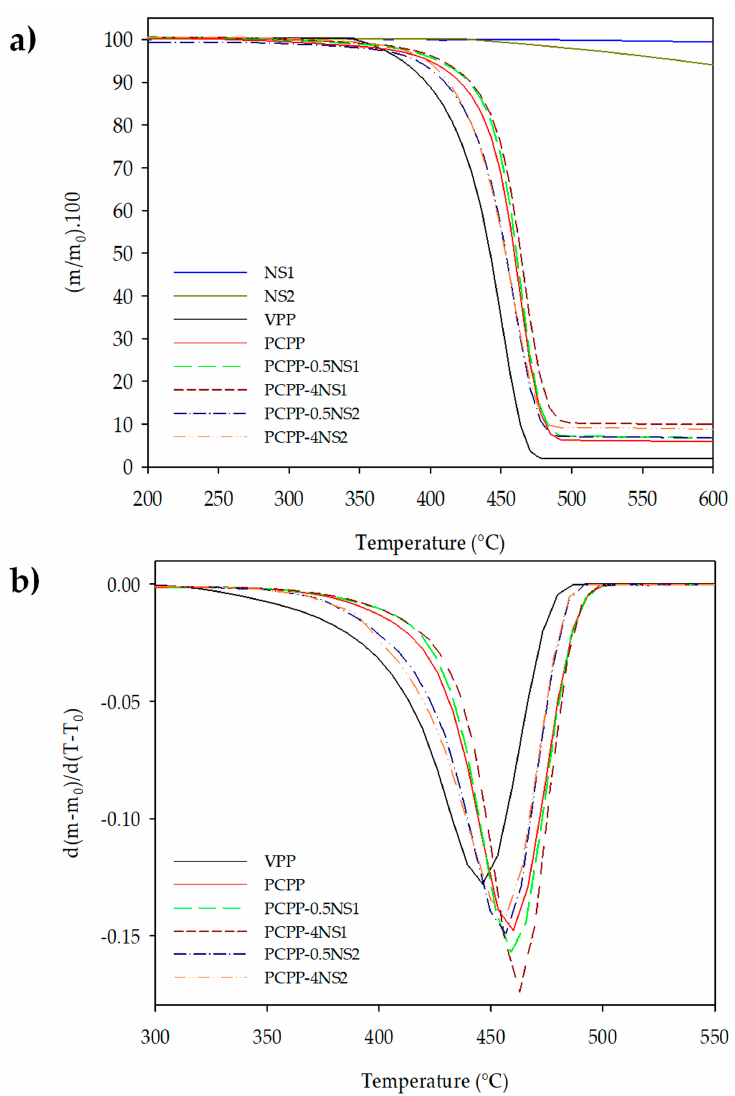
Figure 2. ( a ) TGA and ( b ) DTGA curves of NS1, NS2, control and representative nanocomposite films at 0.5 and 4 wt% of NS.